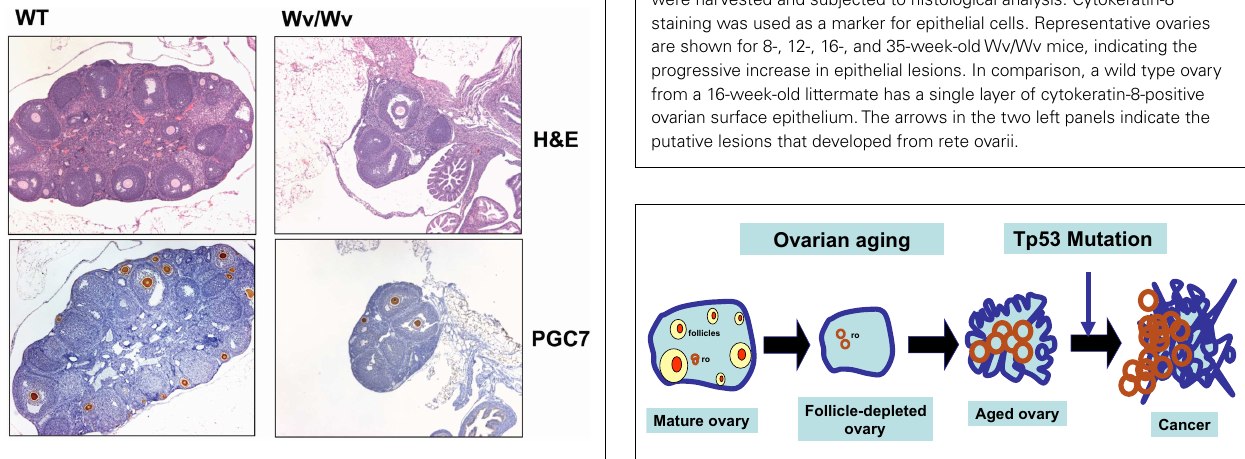
FIGURE 3 |Working model for follicle depletion and ovarian aging in ovarian tumorigenesis . A schematic illustration of the consequences of follicle depletion in the development of ovarian tumors is presented. Upon depletion of ovarian follicles, ovarian surface and rete ovarii (ro) epithelia undergo remodeling and morphological changes.Wv ovarian epithelial tumors may be derived from both surface and rete ovarii (ro). Genetic mutations, such asTp53 mutation, will promote the benign epithelial lesions to develop into malignant